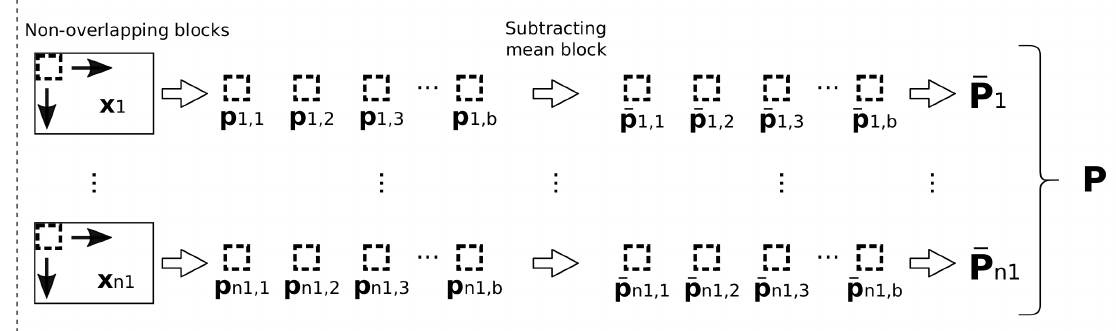
Figure 6. Detailed patch factorization